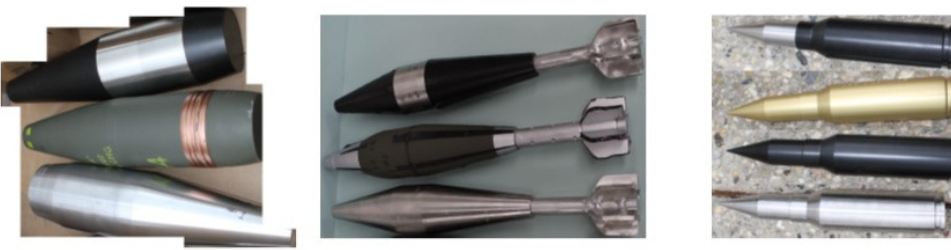
Figure 3. Surface ( a ) east-west wind component and ( b ) north-south wind component for the study area from the NOAA PACF1 buoy (blue curves) [18] and the ERA5 reanalysis data with 0.25° reso- lution from the European Centre for Medium-Range Weather Forecasts (ECMWF) (red curves) [19].